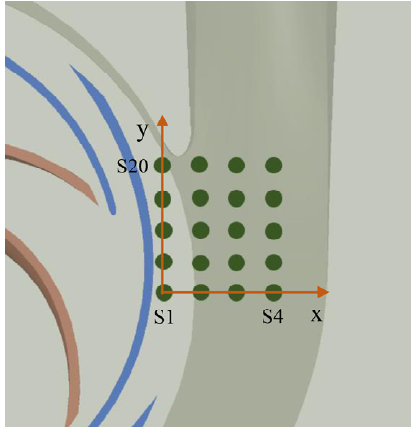
Figure 12. Diagram of the twenty measuring points.